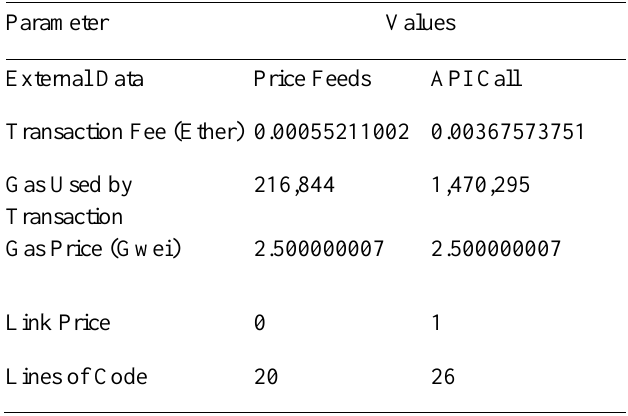
Contract creation